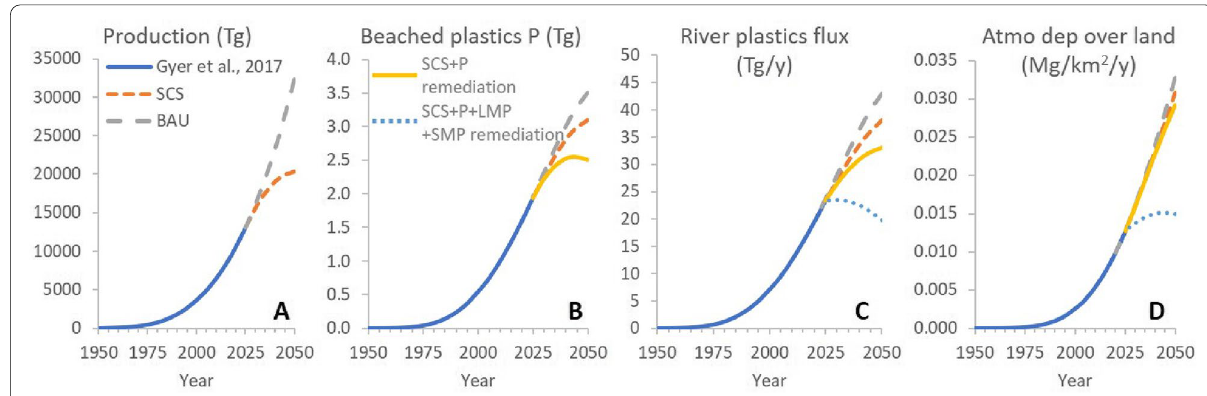
Fig. 5 Box model results for plastics cycling from 1950 to 2050. From 1950 to 2015 the model estimates the dispersal of P, LMP and SMP in different Earth surface reservoirs, based on known plastics production and waste generation. From 2015 to 2050 the model illustrates plastics production ( A ), amount of beached macroplastics, P ( B ), the total, P LMP SMP, annual river plastics flux ( C ), and atmospheric SMP deposition (atmo dep) to + + remote land surfaces ( D ), for two different scenarios with different plastics production and waste disposal trajectories: business as usual (BAU, grey dashed line) [3], and systems change scenario (SCS, orange short dashed line) [4], the latter representing feasible plastics policy implementation. Despite the large difference in plastics production towards 2050, 991 vs 168 Tg y − 1 in BAU and SCS, environmental stocks and fluxes recover only slowly due to the large mobilization of mismanaged plastics from the terrestrial discarded plastics pools that continue to cycle between land, ocean and atmosphere. Two remediation scenarios are simulated for the 2025 to 2050 period: Discarded P remediation at a rate of 3% per year (yellow solid line), and combined discarded P, LMP and SMP remediation at a rate of 3% per year. See Methods and SI 2 for details on BAU and